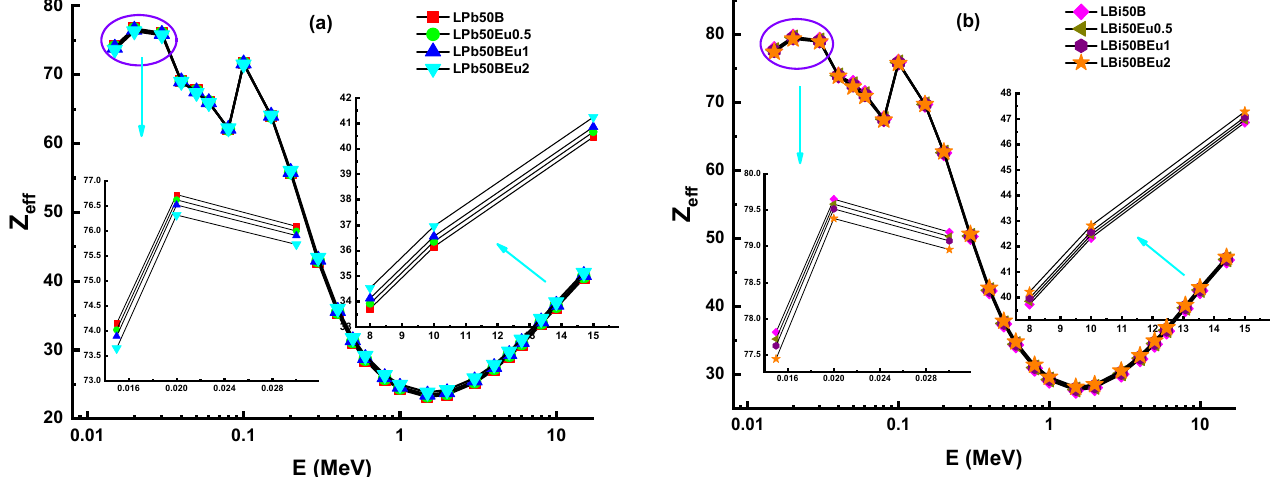
Figure 6. Variation of effective atomic number ( Z eff ) against photon energy for ( a ) LPb50BEu and ( b ) LBi50BEu glasses. When all gamma-shielding parameters are evaluated together, the LBi50BEu glasses show a superior performance compared to LPb50BEu glasses in reducing photons. Besides, the protection capability of L(Pb/Bi)50BEu glasses against uncharged (fast neutrons) and charged particles (alpha and protons) was also evaluated. For this purpose, the macroscopic removal cross-section ( Σ R ) of glasses for fast neutrons was calculated